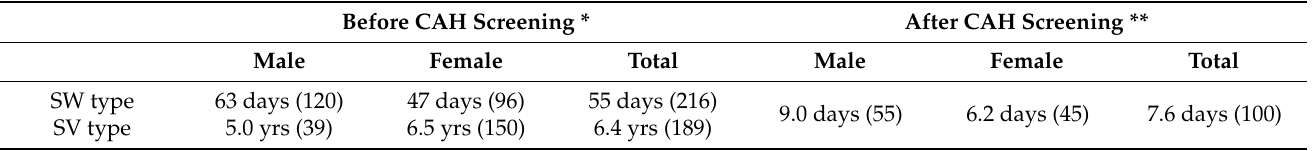
Table 2. Age at diagnosis before and after implementation of the